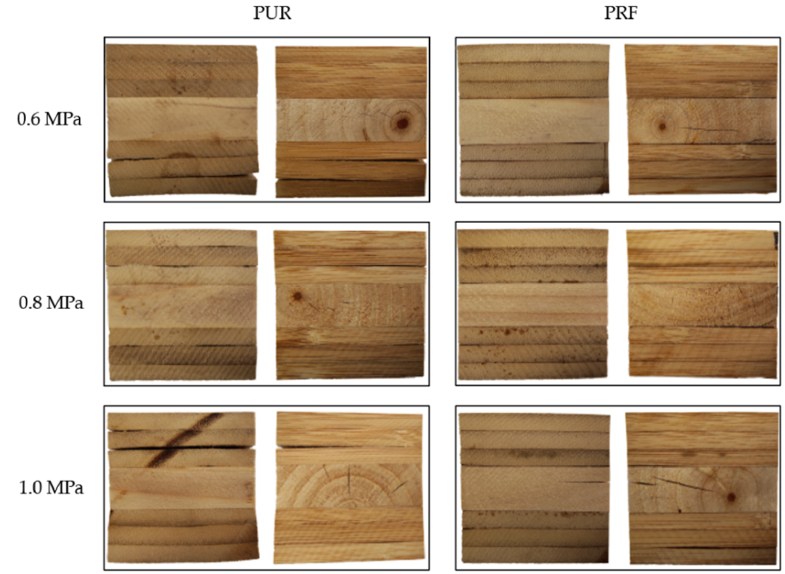
Figure 6. End and side views of specimens after delamination. Table 6. ANOVA of the delamination characteristics of CLBT under different bonding pressures.